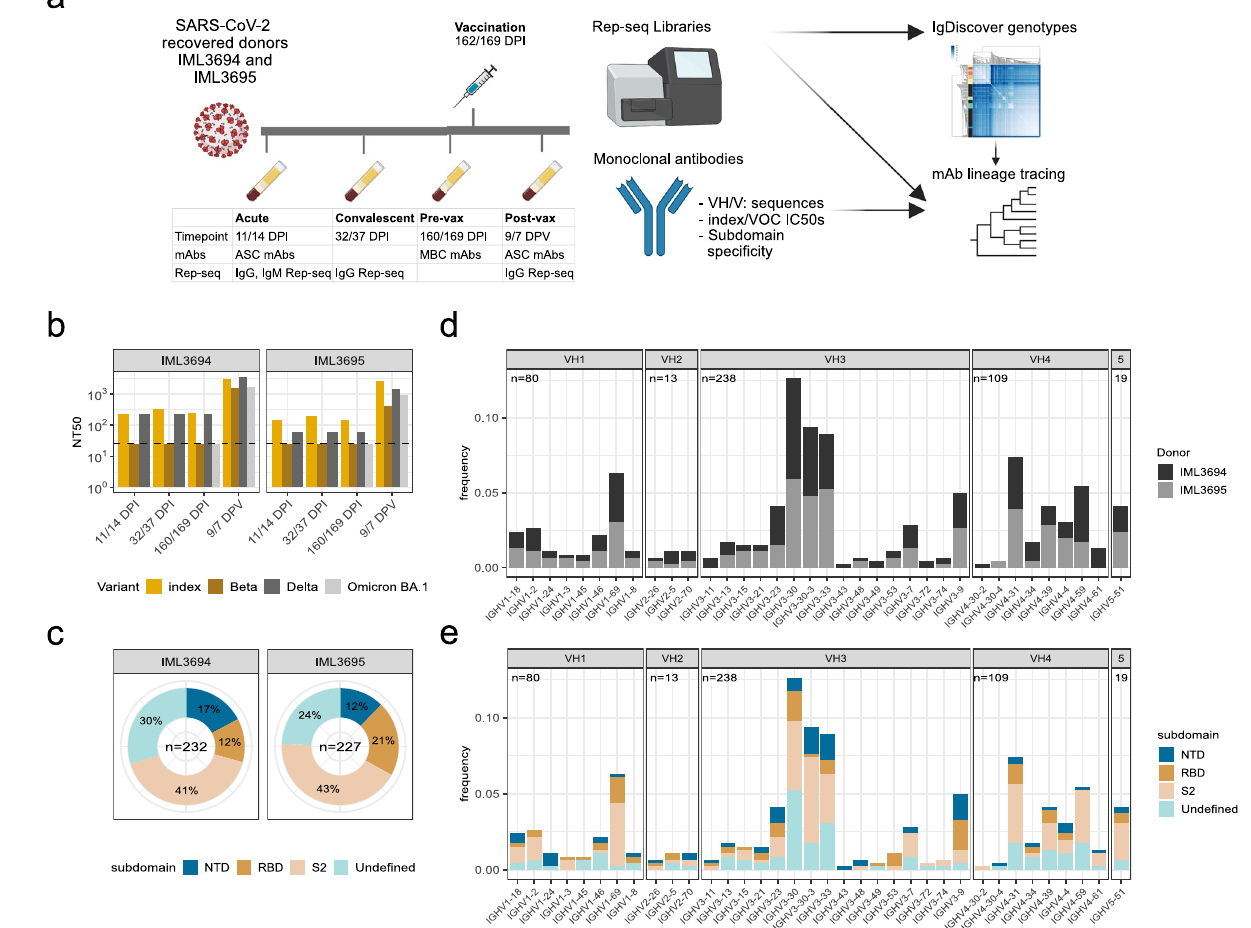
Fig. 1 | Study design, serum neutralizing activity, and properties of spike- binding monoclonal antibodies (mAbs). a Schematic of study design with time- points for infection and vaccination, mAb isolation, and samples for Rep-seq. b IML3694 and IML3695 ’ s serum neutralizing antibody values against index SARS-